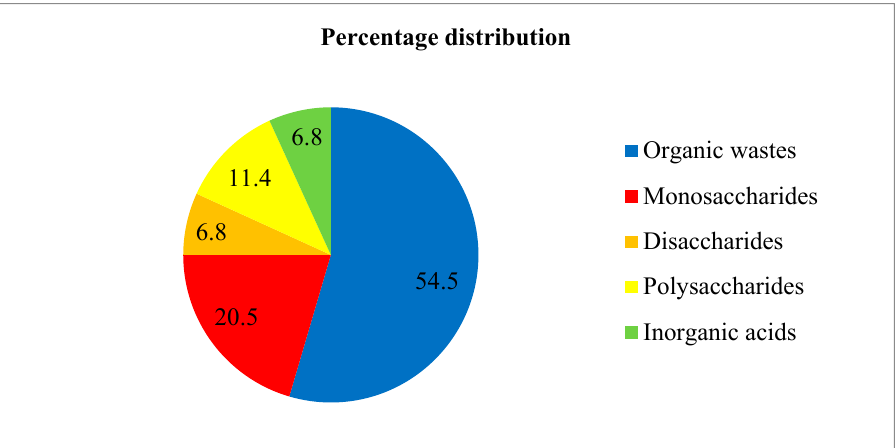
Figure 3. Percentage distribution of available literature reports on hydrogen production from different substrates using the mixed-culture system.